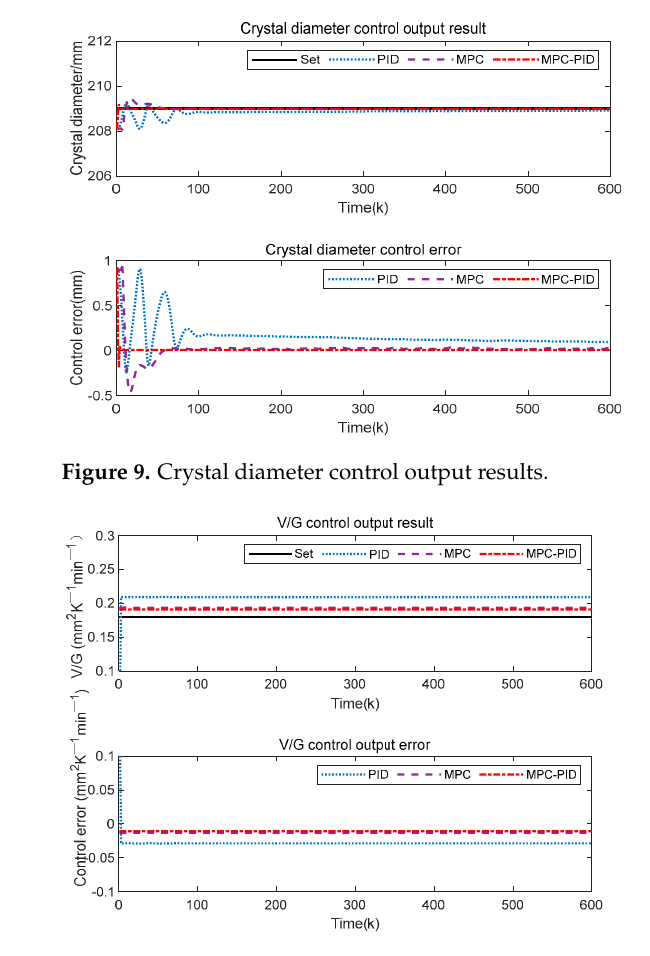
Figure 10. V/G value control output result.